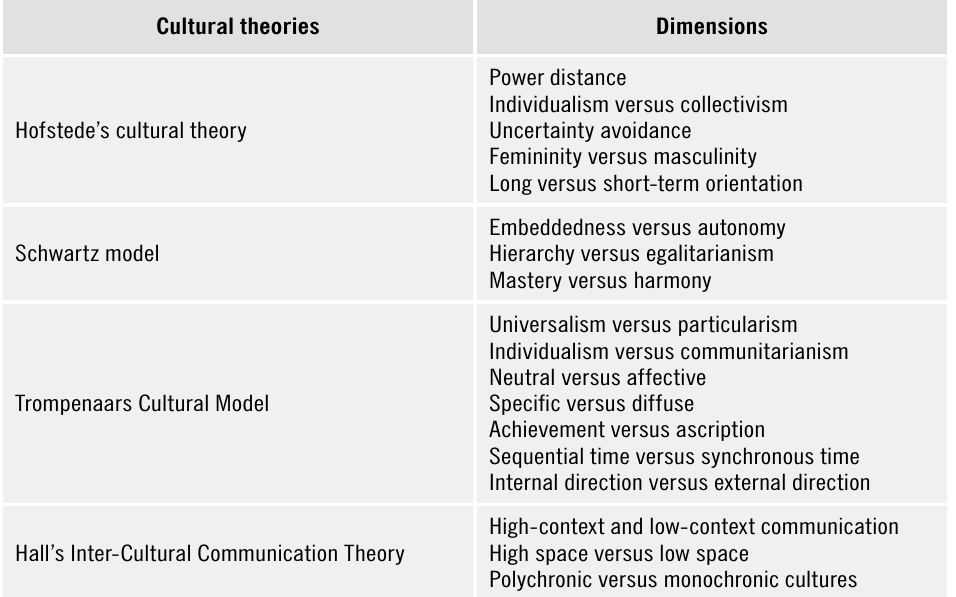
Table 2. Cultural theory